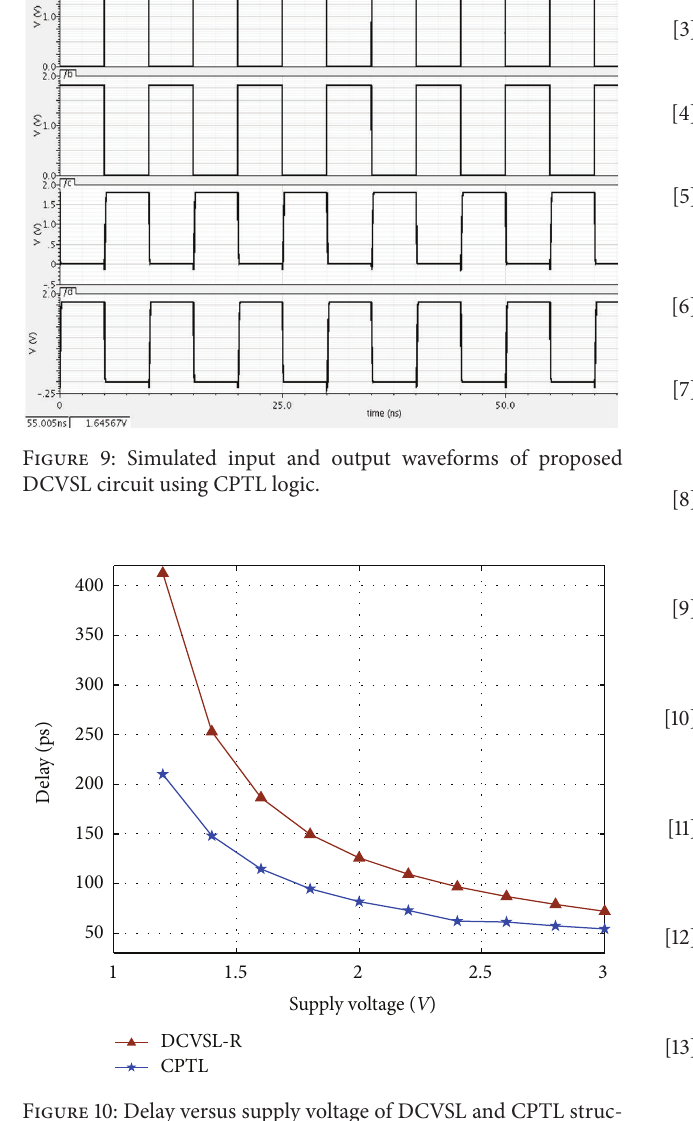
Figure 10: Delay versus supply voltage of DCVSL and CPTL struc-